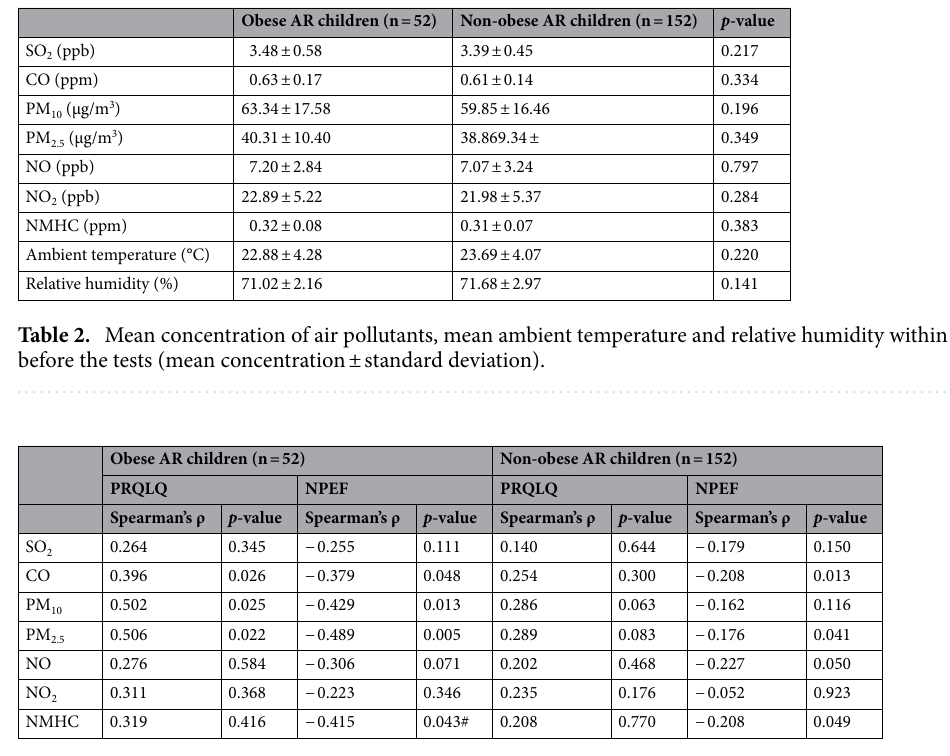
Table 3. Correlation between PRQLQ score, NPEF rates and mean air pollutant concentrations (within 7 days before the tests). Spearman’s ρ: Spearman’s rank correlation coefficient p -value: adjust for sex, age, parental occupation, second-hand smoke exposure, combined with asthma, mean ambient temperature and relative humidity within 7 days before the tests.